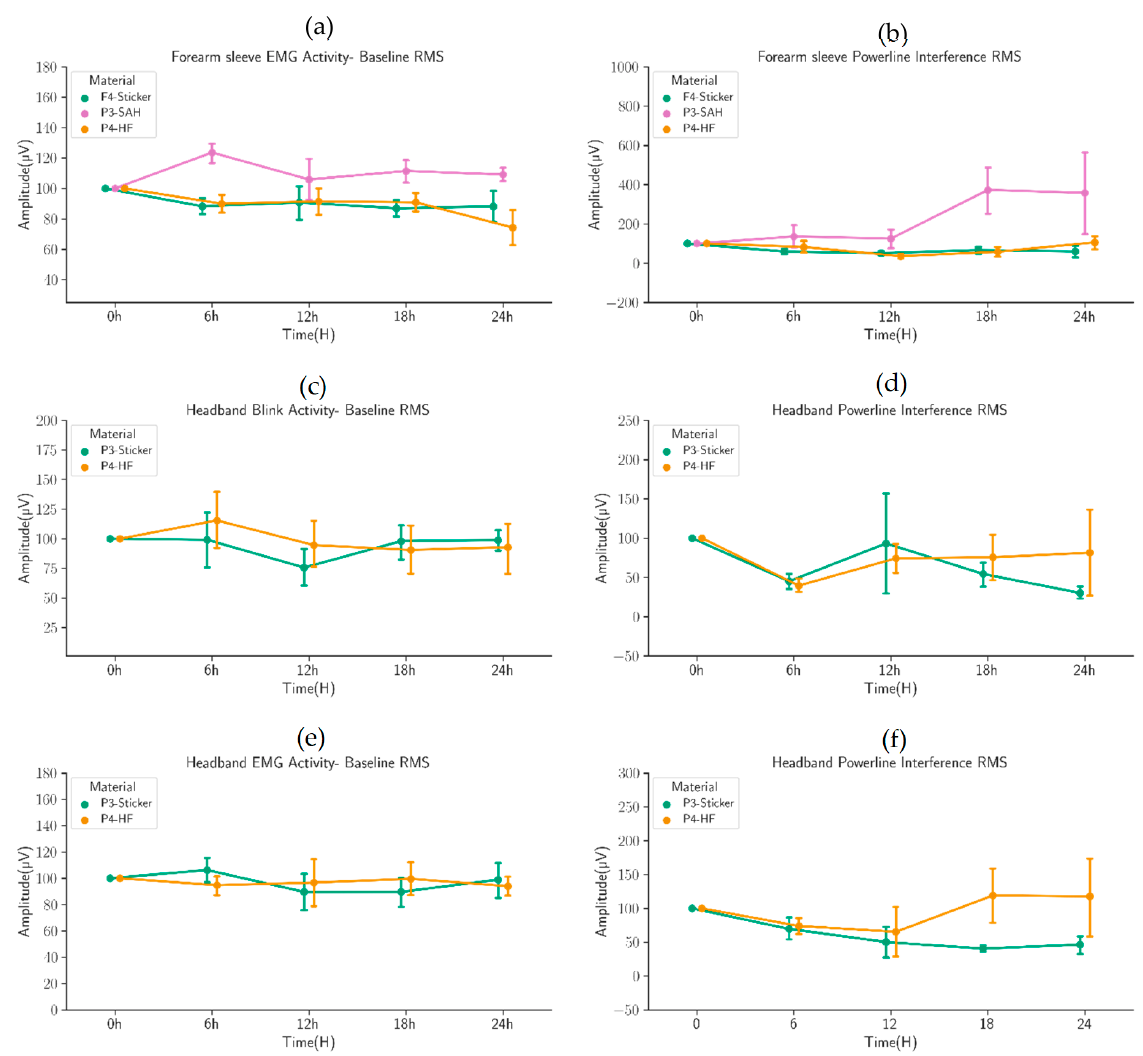
Figure 7. Comparison of contact medium in measuring activations using forearm sleeve and headband. The values are expressed as a percentage of the baseline activation. Note the general stability of the measures over 24 h recordings, suggesting that the contact media are comparable in biosignal recordings. ( a ) Forearm EMG activity ‐ baseline RMS of Sticker electrode, SAH and HF. ( b ) Forearm EMG powerline interference RMS of Sticker electrode, SAH and HF. ( c ) Headband blink Activity ‐ Baseline RMS of Sticker electrode, and HF. ( d ) Headband blink powerline interference RMS of Sticker electrode, and HF. ( e ) Headband EMG Activity ‐ Baseline RMS of Sticker electrode, and HF. ( f ) Headband EMG powerline interference RMS of Sticker electrode, and HF.